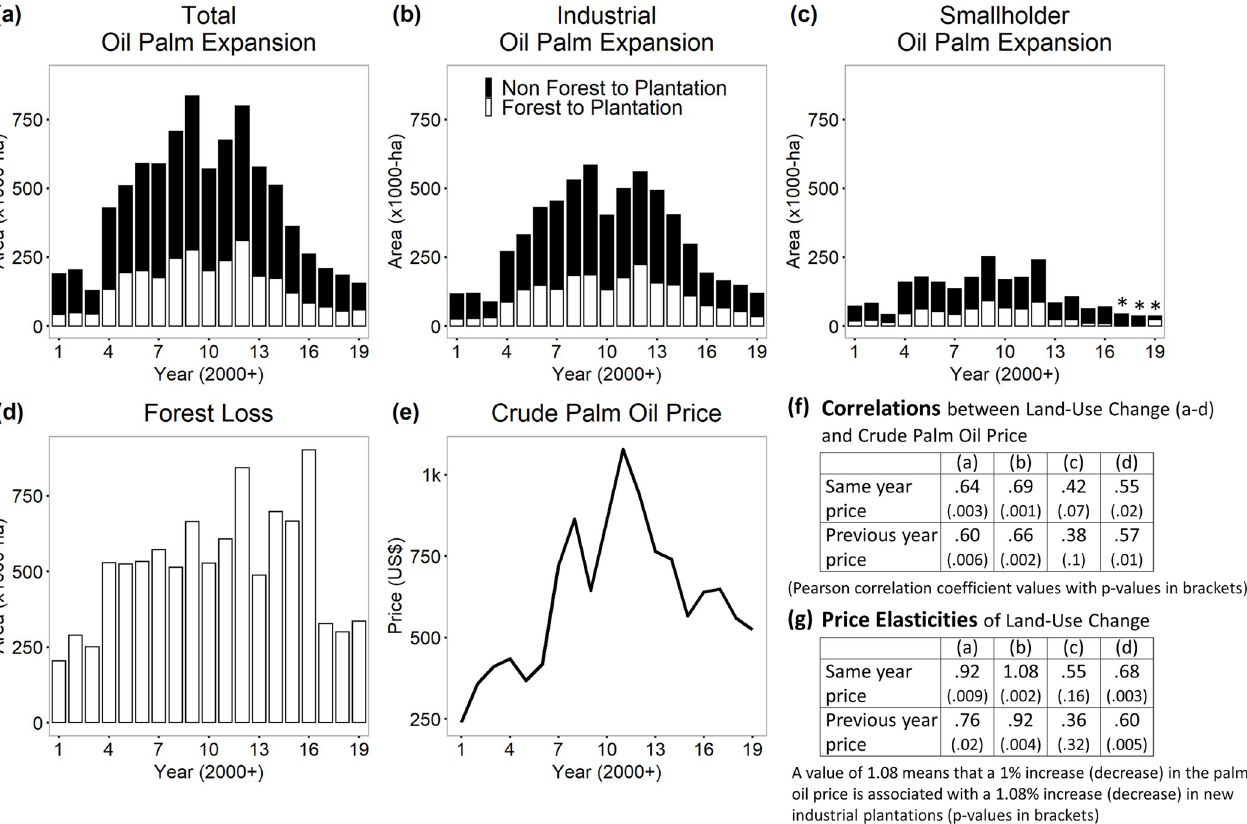
Fig 2. Time-series of Indonesia’s land-cover/use change from 2001 to 2019. Expansion of oil palm plantations by year (a), split between industrial and smallholder (b,c). Forest loss (d). Mean annual Crude Palm Oil price (e). Correlations/elasticities with the previously shown land-cover change estimates (f,g). Price calculated from monthly prices in USD using IMF data [29]. In insets (a,b,c) white bars represent the areas of forest cleared and converted to plantations in the same year. This rapid conversion constitutes 29% of all forest loss detected during 2001–2019. The black bars represent areas of non-forest converted to oil palm. Ninety six percent (5.39 Mha) of those non-forest areas were non-forest in 2000, 4% (0.24 Mha) were forest cleared after 2000 and converted to plantations more slowly (after 2 to 18 years). These non-forest areas include conversion of young regrowth, mixed gardens, agroforests, and rubber plantations. Asteriks ( � ) indicate that the area of smallholder expansion in 2017, 2018, 2019 is likely underestimated. We note that the 2016 peak in forest loss (d) includes losses of late 2015, when fire burned large areas of forest in Kalimantan. Much of these losses were recorded only the following year by the Tree Loss dataset used to calculate forest loss because of cloud